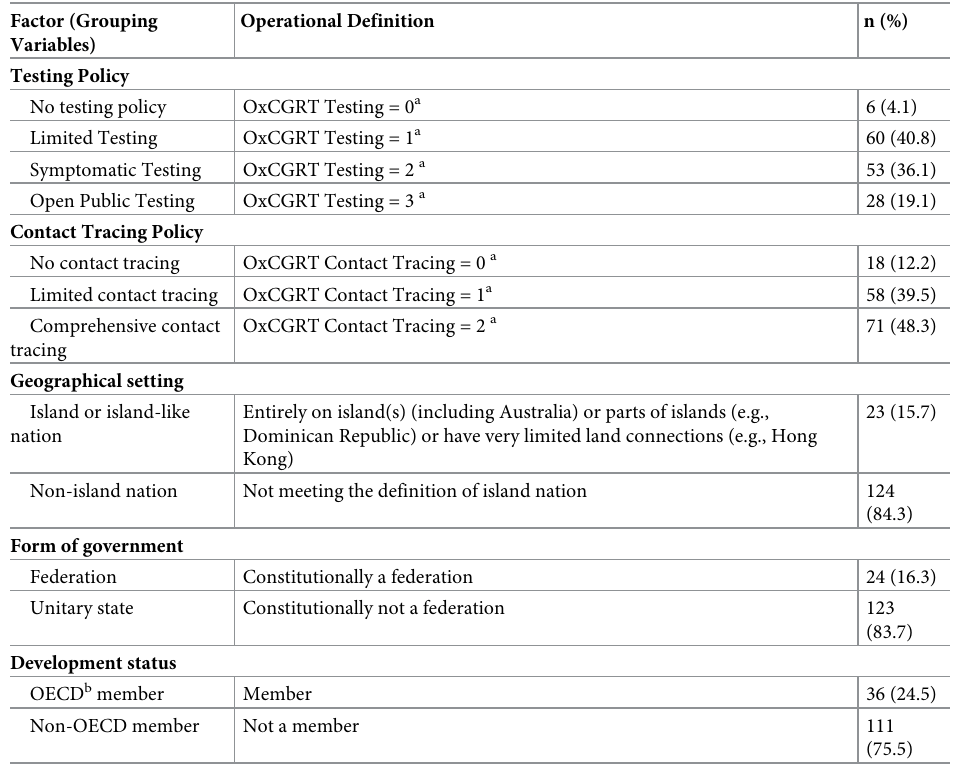
Table 1. Definitions of grouping variables for multiple linear regression of COVID-19 Testing Index (n =